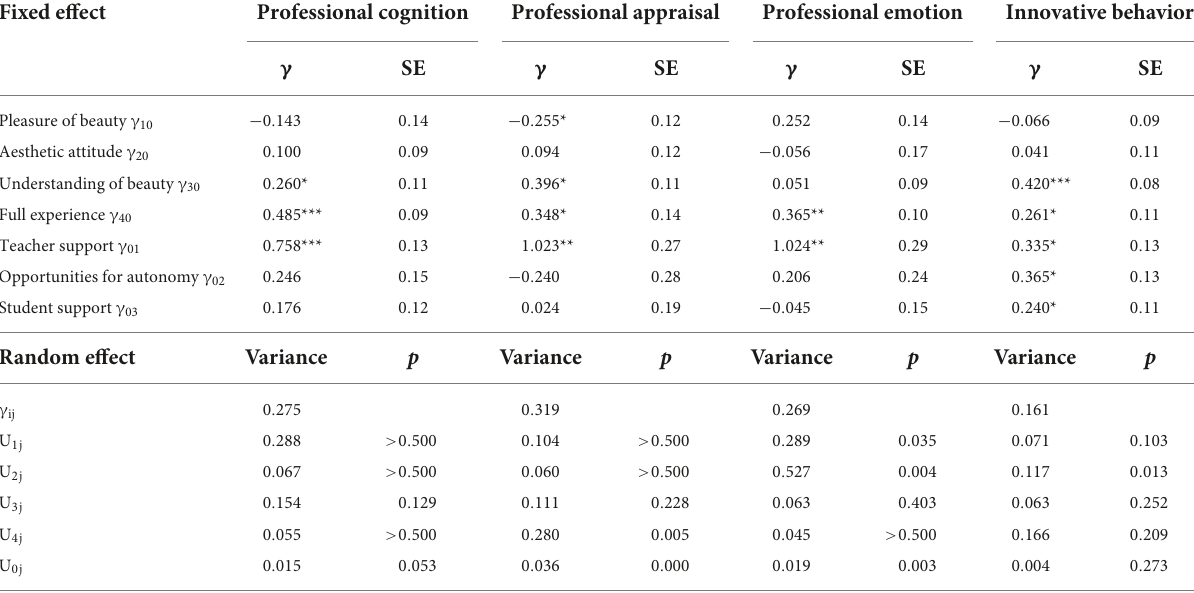
TABLE 2 Summary of intercept prediction model.